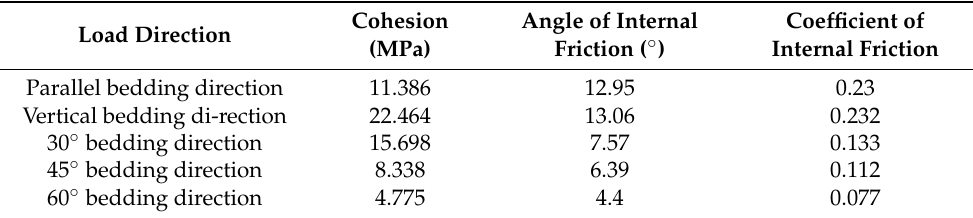
Table 2. Experimental results of rock mechanics parameters in different loading directions.